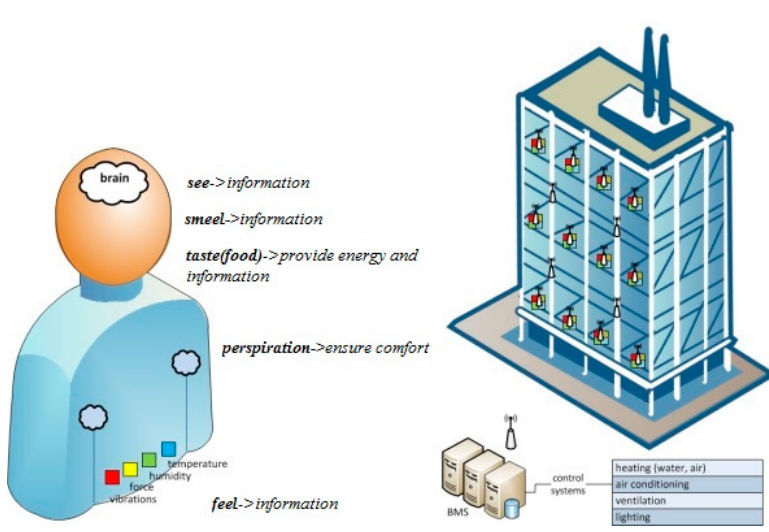
Figure 1 . Typical building management system (BMS) infrastructure. Figure 1. Typical building management system (BMS)